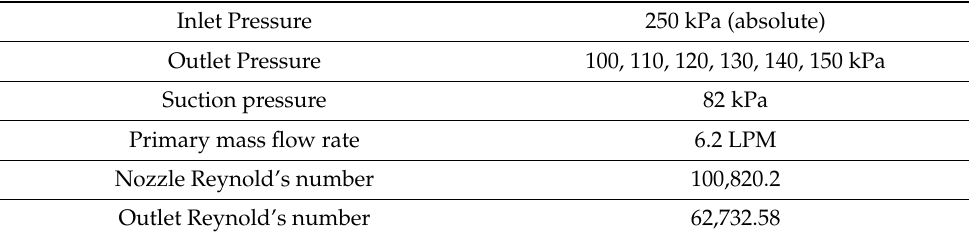
Table 1. Boundary